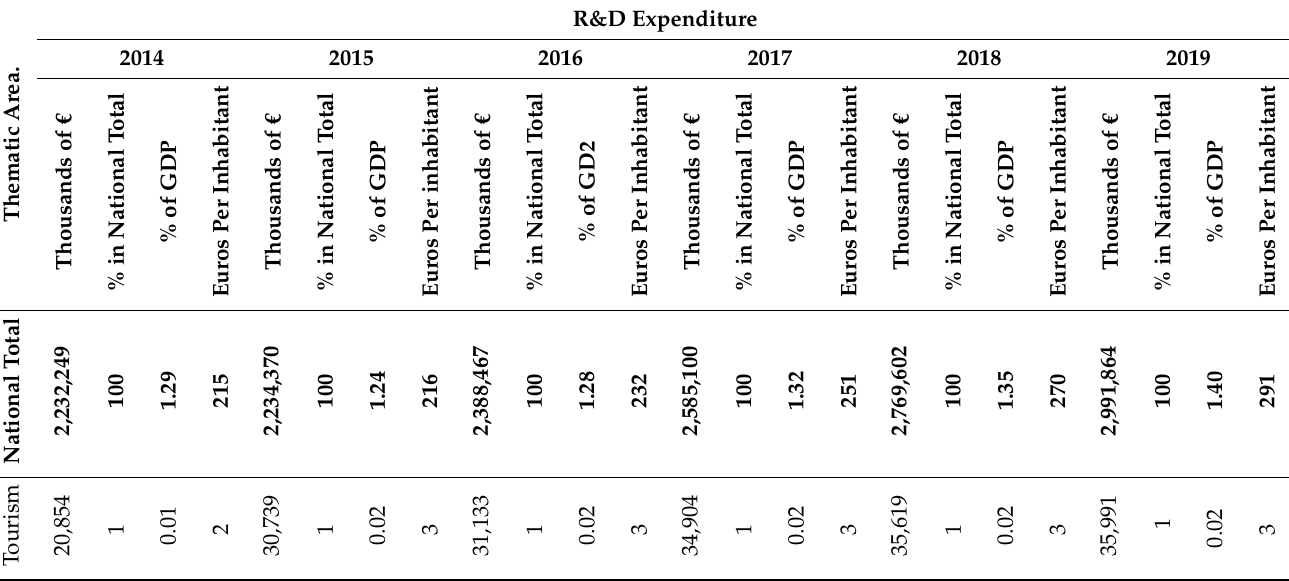
Table A1. R&D Expenditure in Portugal, from 2014 to